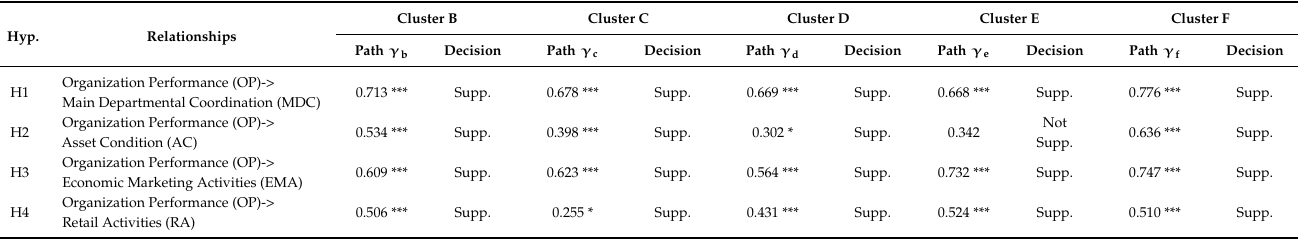
Table 5. Hypothesis results of